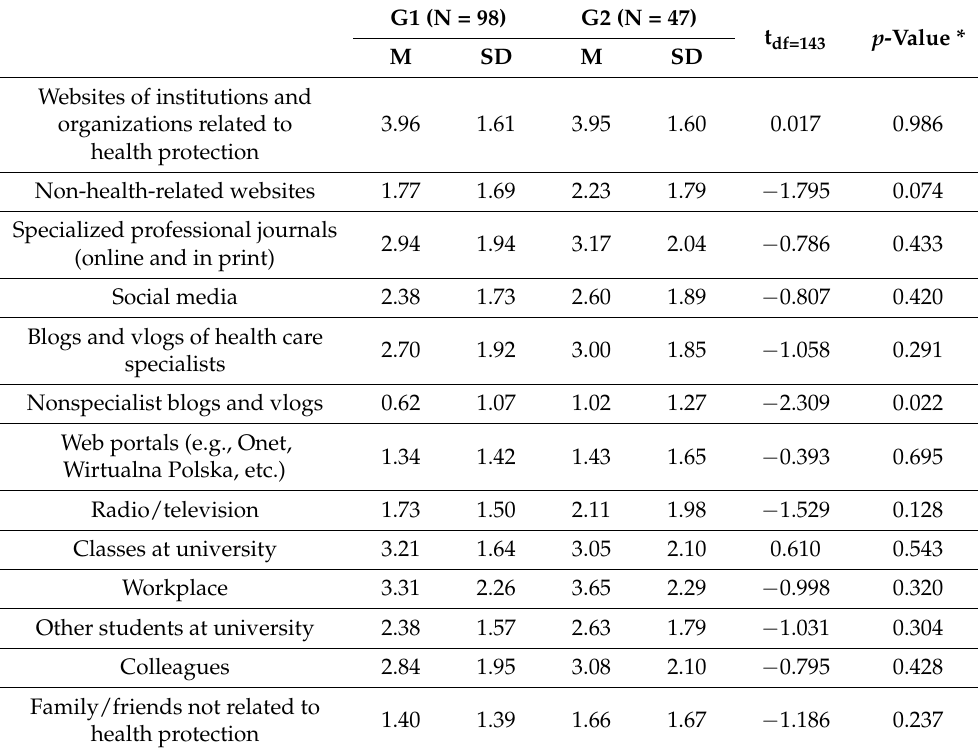
Table 6. Frequency of using sources of information on